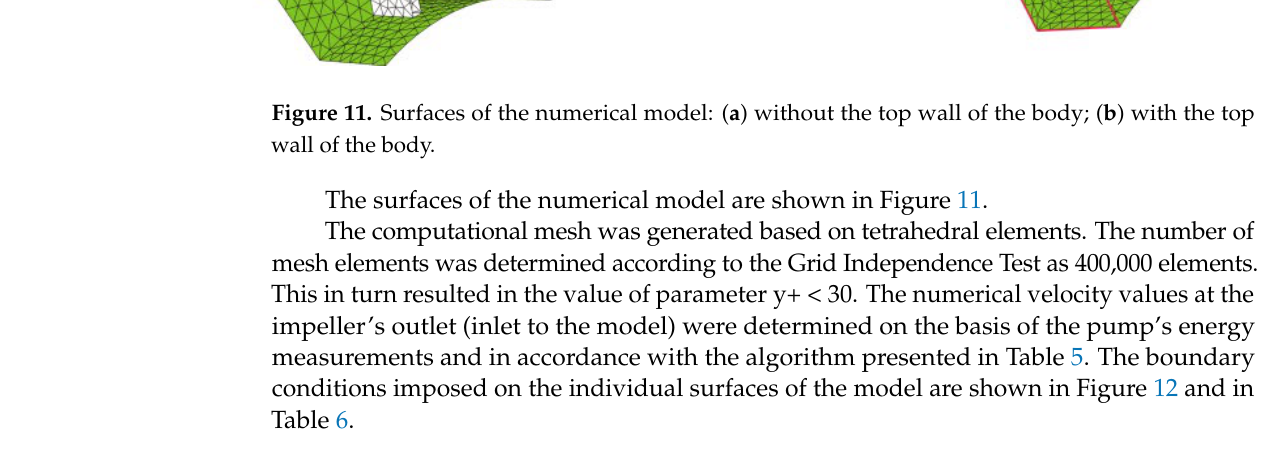
Table 5. Algorithm for determining the velocity components ( c m 3 , c u 3 ) on the impeller’s outlet